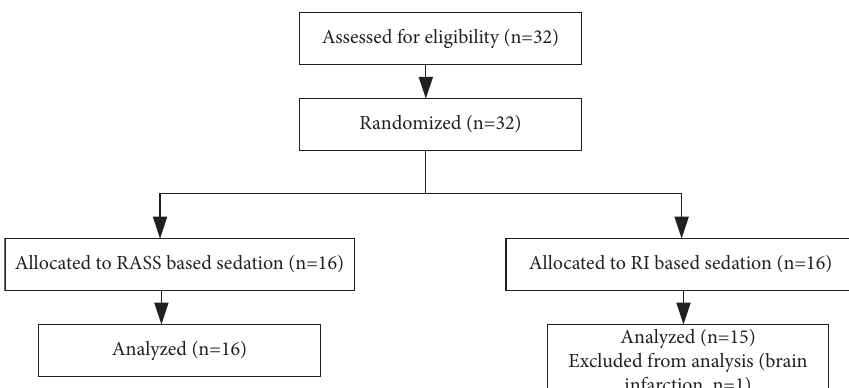
Figure 1: Consort diagram of the